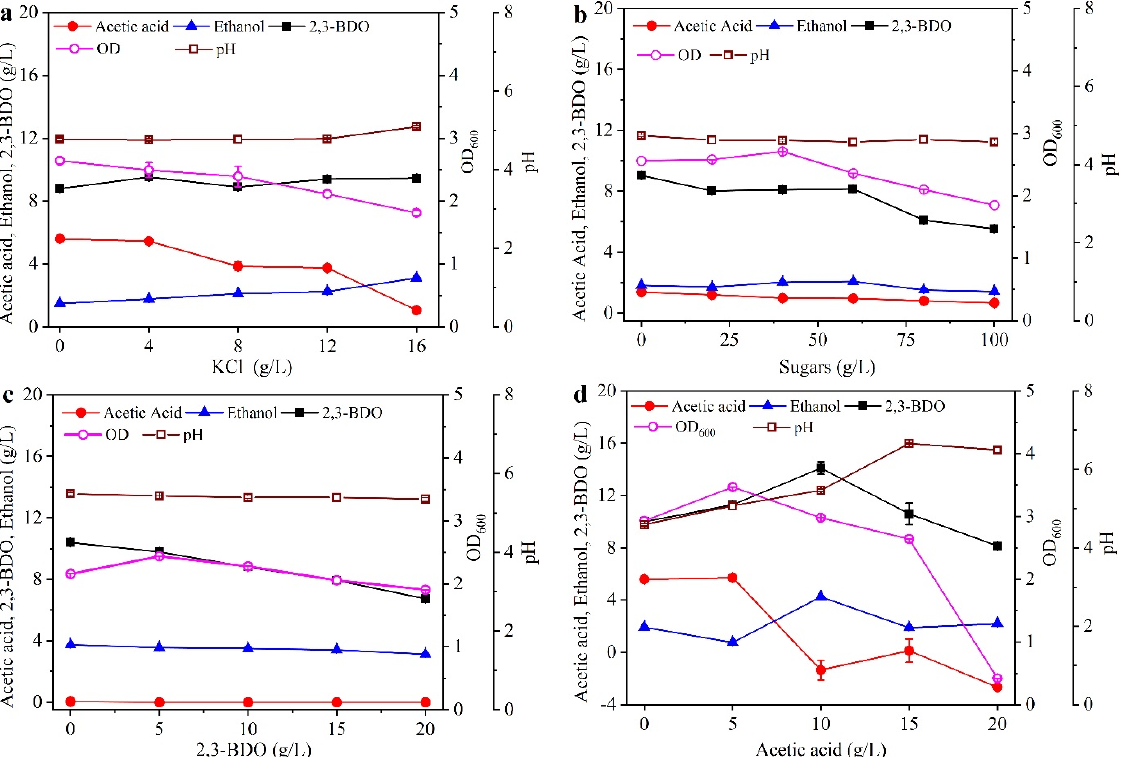
Figure 6. Effect of exogenous KCl ( a ), sugars ( b ), 2,3-BDO ( c ), and acetic acid ( d ) on 2,3-BDO production. The basal medium was the same as that in Figure 1c with 35 g/L sugars in molasses. In ( b ), the sugars in the horizontal axis mean the simulated sugars in molasses, which were further added to the initial 35 g/L real molasses solution in Figure 1c. In ( c , d ), the concentration of 2,3-BDO or acetic acid in the vertical axis means the final concentration of 2,3-BDO or acetic acid in the broth subtracted its initial concentration in the medium. The fermentations were carried out in 250 mL screw-cap bottles. Data are given as the mean ± SD, n = 3.